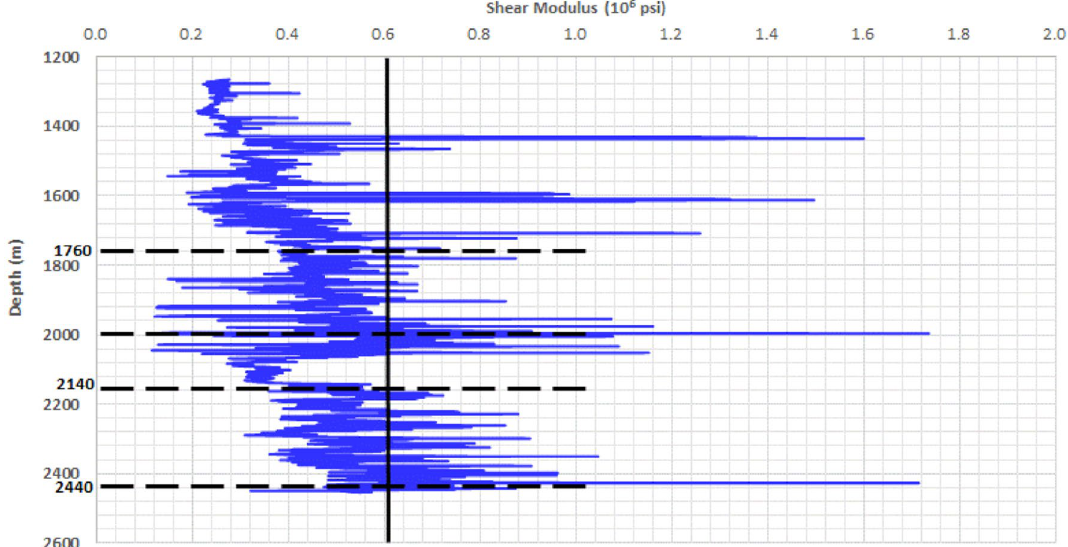
Fig. 13 Shear modulus of Field